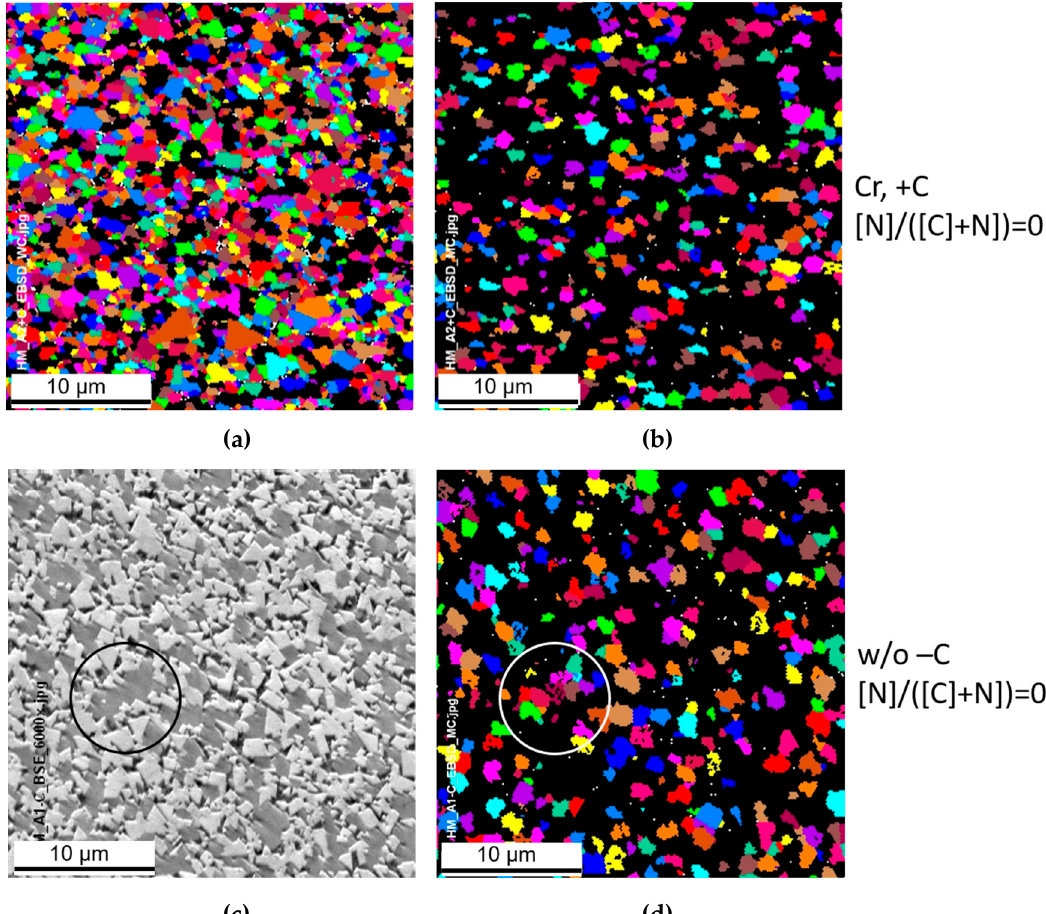
Figure 6. Electron backscatter di ff raction (EBSD) and back-scattered electrons (BSE) patterns of WC-MC / M(C,N)-Co hardmetals: ( a ) and ( b ) Cr doping, high C activity (Ms ≈ 88%, + C), ( a ) coloured WC phase, black MC / (C,N) phase; ( b ) coloured MC / M(C,N) phase, black WC phase; ( c ) and ( d ) no doping, low C activity (Ms ≈ 75%, –C), ( c ) SEM-BSE image, ( d ) coloured MC / M(C,N) phase, black WC phase.